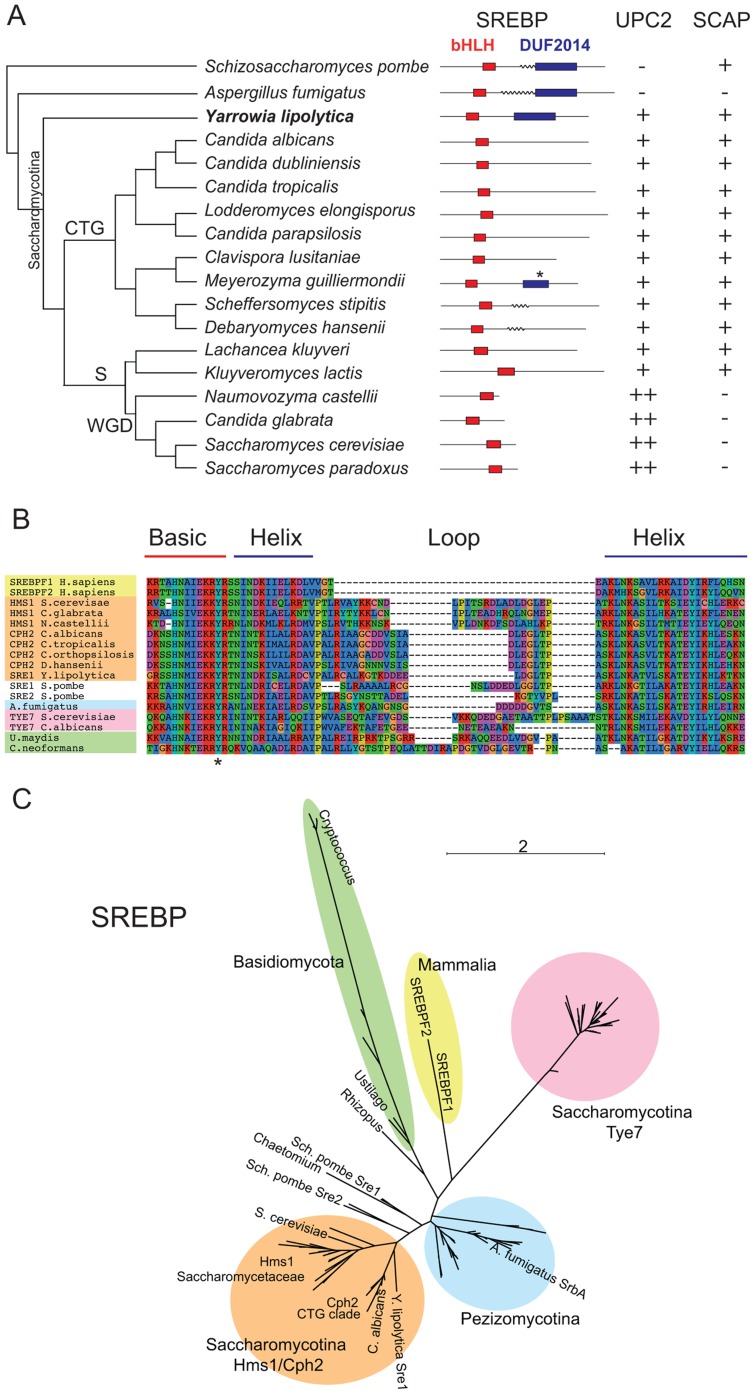
Conservation of sterol regulatory proteins in fungi.(A) Schematic phylogenetic tree of Saccharomycotina species and outgroups. Two domains from the SREBP proteins are shown diagrammatically as red (bHLH) and purple (DUF2014) boxes. Transmembrane domains are indicated by wavy lines; probabilities of <40% are not shown (details in Figure S1). The asterisk indicates a partially conserved DUF2014 domain in M. guilliermondii. The presence of Upc2-like proteins is indicated by + (one ortholog) or ++ (two orthologs). The presence/absence of Scap proteins is indicated with +/−. CTG = CTG clade, S = Saccharomycetaceae, WGD = Whole Genome Duplication clade. (B) Alignment of the bHLH domain from SREBP proteins from mammals (yellow), Basidiomycetes (green) and Ascomycetes (orange, blue, pink, white). The alignment was generated using MUSCLE implemented in SeaView [91]. The conserved Tyr residue is indicated with an asterisk. Clades are colored as in (C). (C) Unrooted phylogenetic tree of fungal SREBP-like proteins and mammalian SREBPF1/2. The tree was constructed from an alignment of bHLH regions (133 amino acid sites) by a maximum likelihood method. All sequences contain the atypical Tyr residue shown in (B). See Supplementary Figure S6 for taxon names and branch support values.